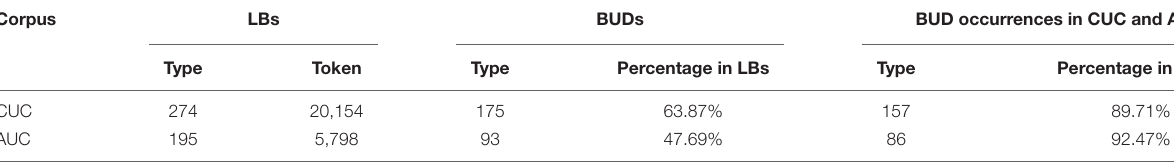
TABLE 4 | Number of frequently used LBs and BUDs.